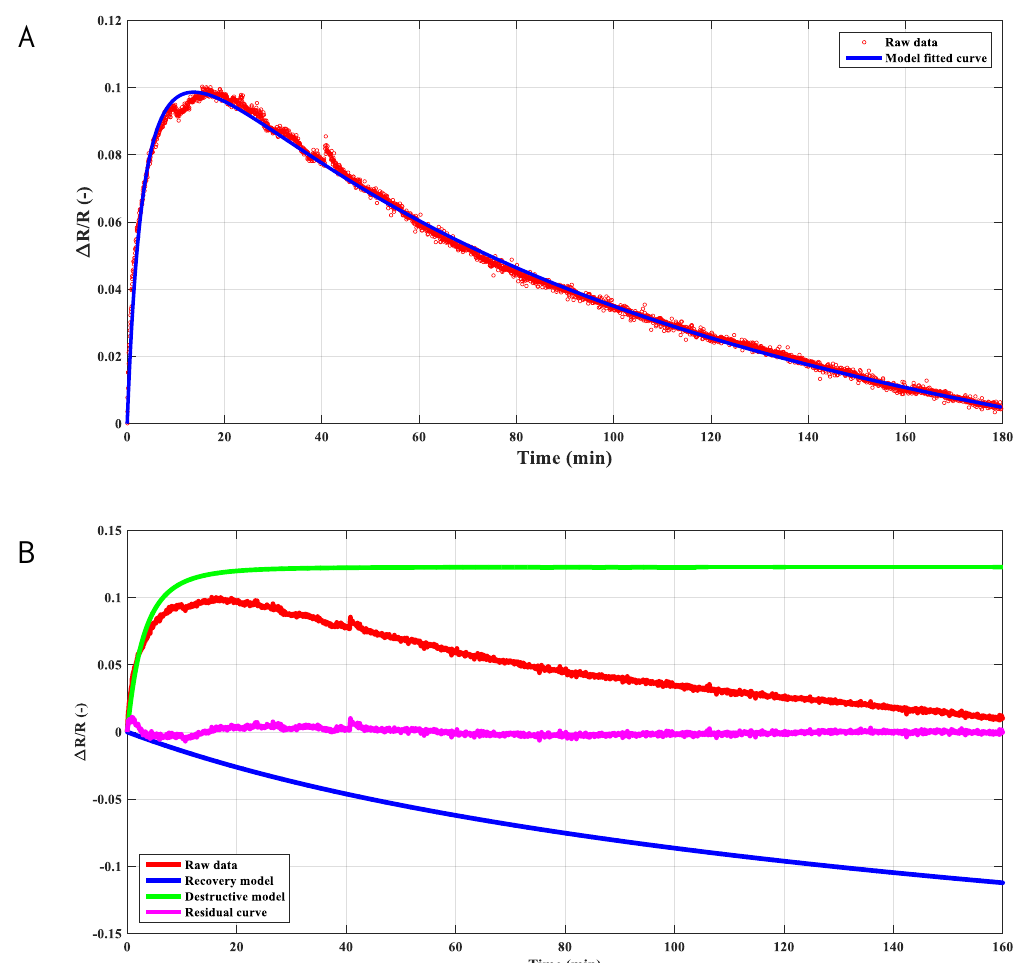
Figure 6. Resistivity variation with time under the compressive force of 2000 N at 100 °C. ( A ) The proposed model matches well with the experimental data. ( B ) The synergistic effect of the destruction and reformation of the conductive network contributed the global resistivity for the composite. Both processes can be extracted based on the proposed model, and little residual error can be found .